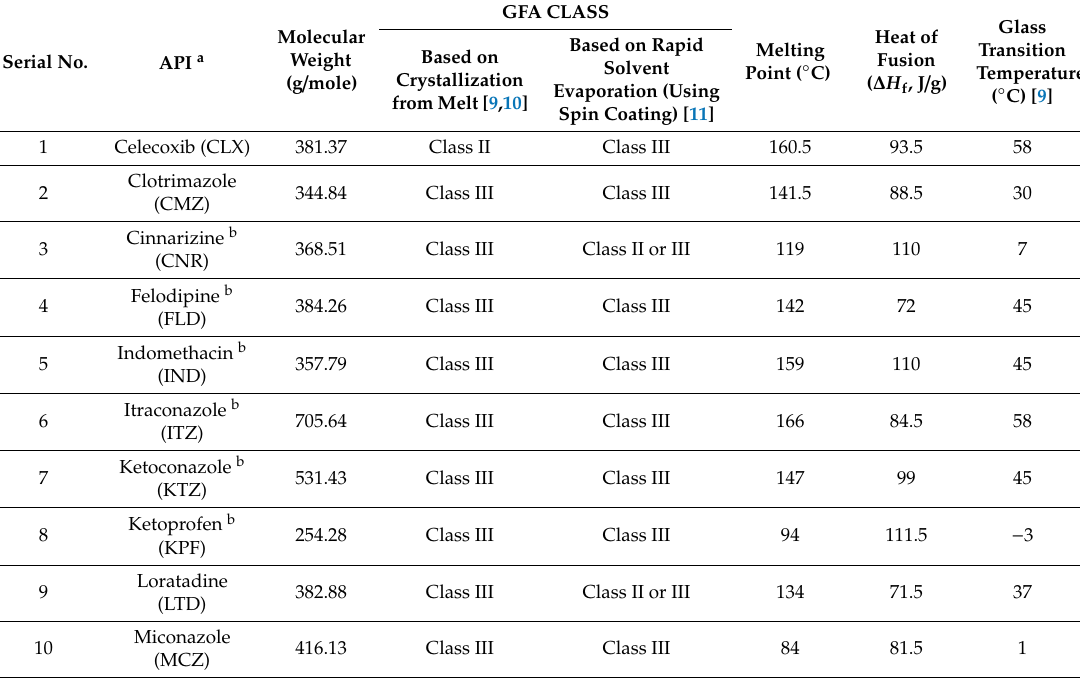
Table 1. List of active pharmaceutical ingredients (APIs) selected for the study.